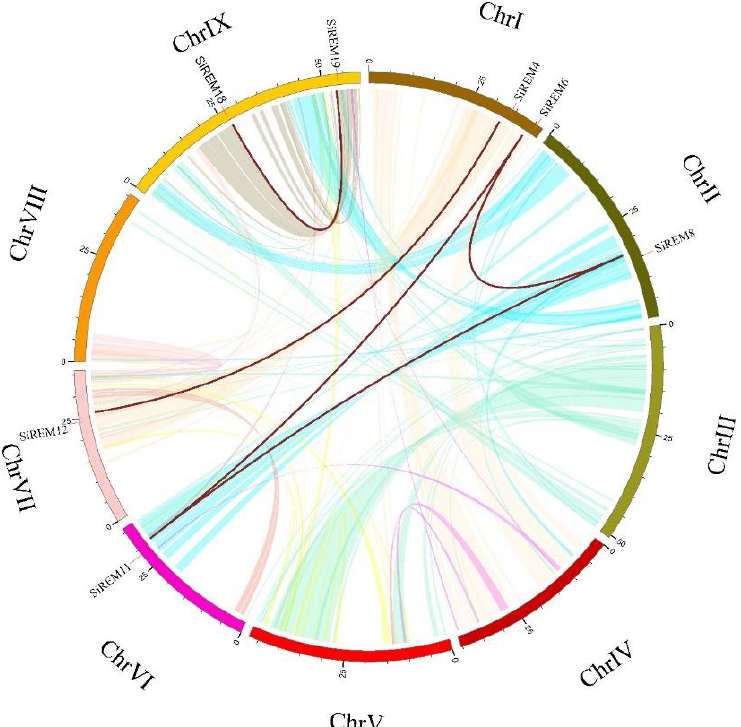
Figure 3. Interchromosomal relationships of millet remorin genes. Red lines represent replicated remorin gene pairs, and other lines represent all common blocks in the millet genome. The chromosome number is marked at the side of each chromosome.